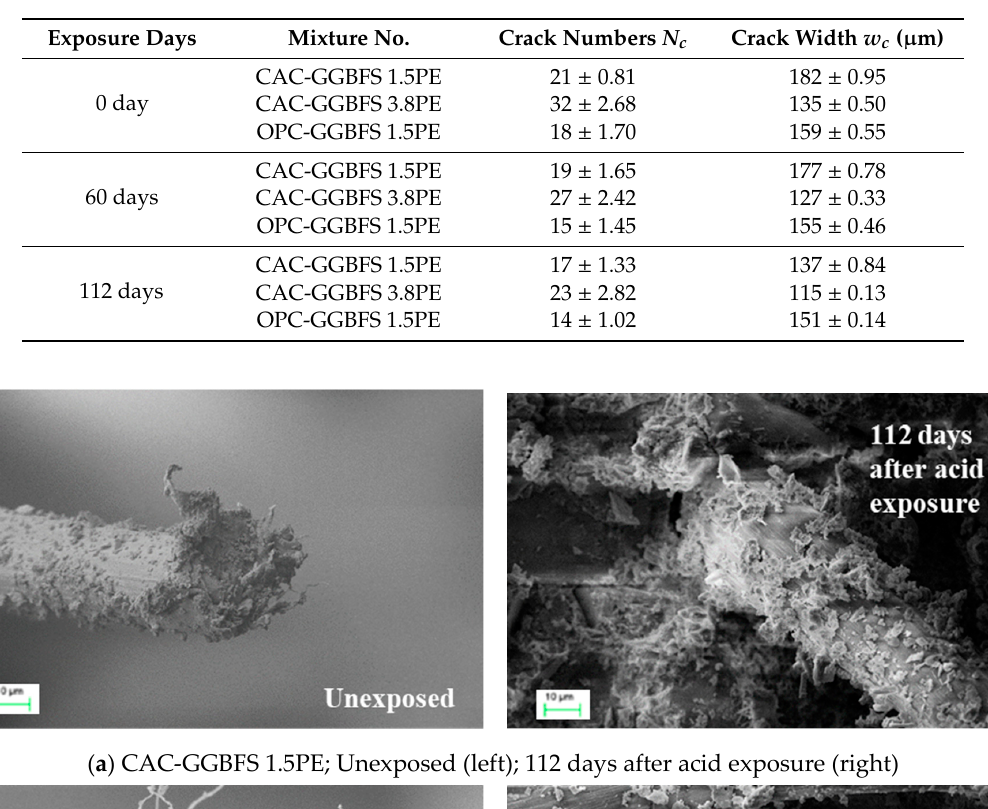
Table 6. Crack information of fibre reinforced mortar before and after sulfuric acid exposure.